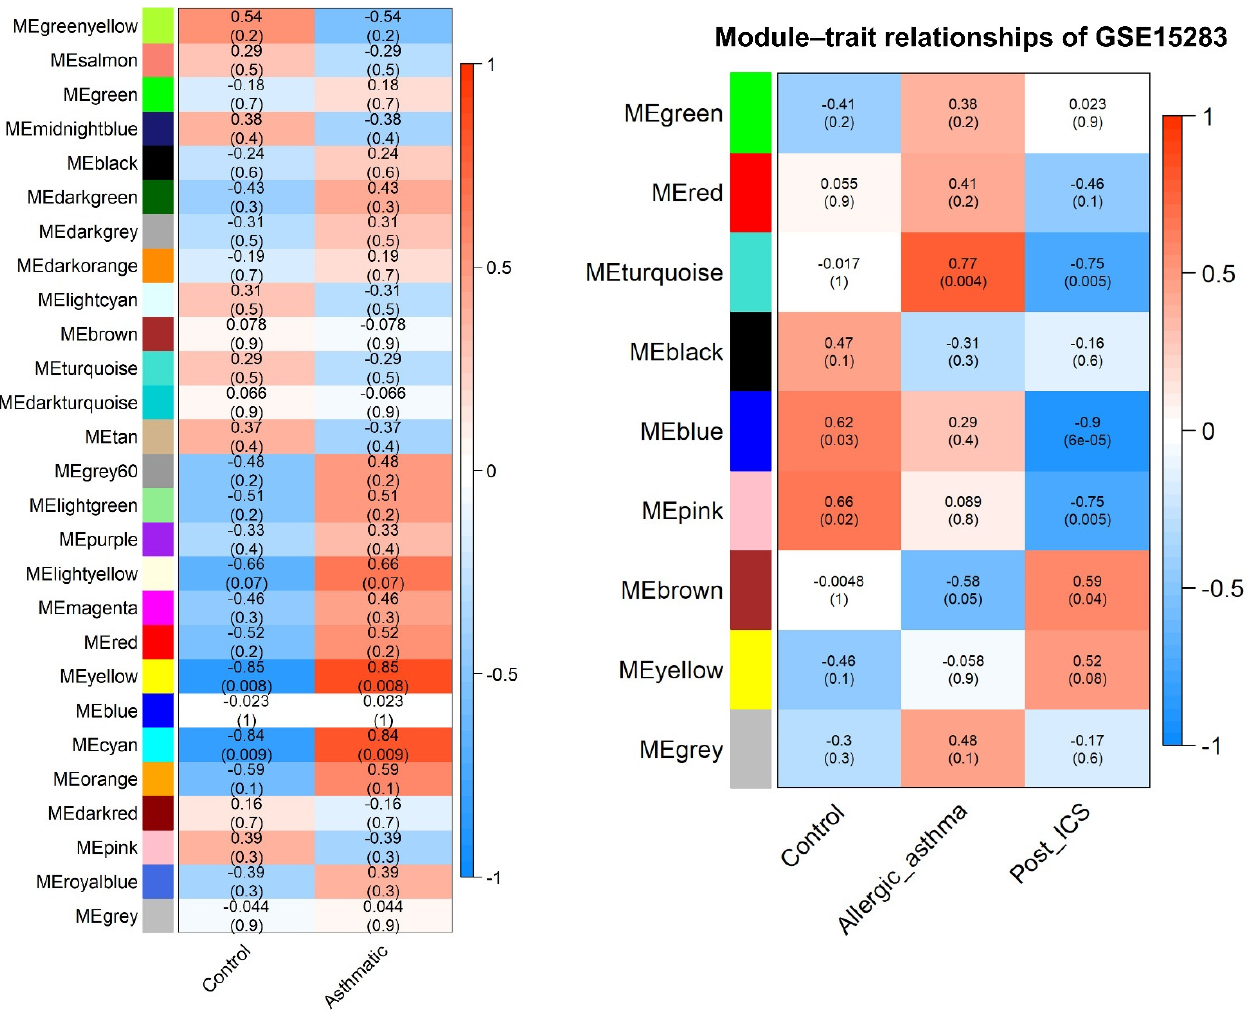
Figure 7. Pearson’s correlation heatmap between dataset groups and color modules.